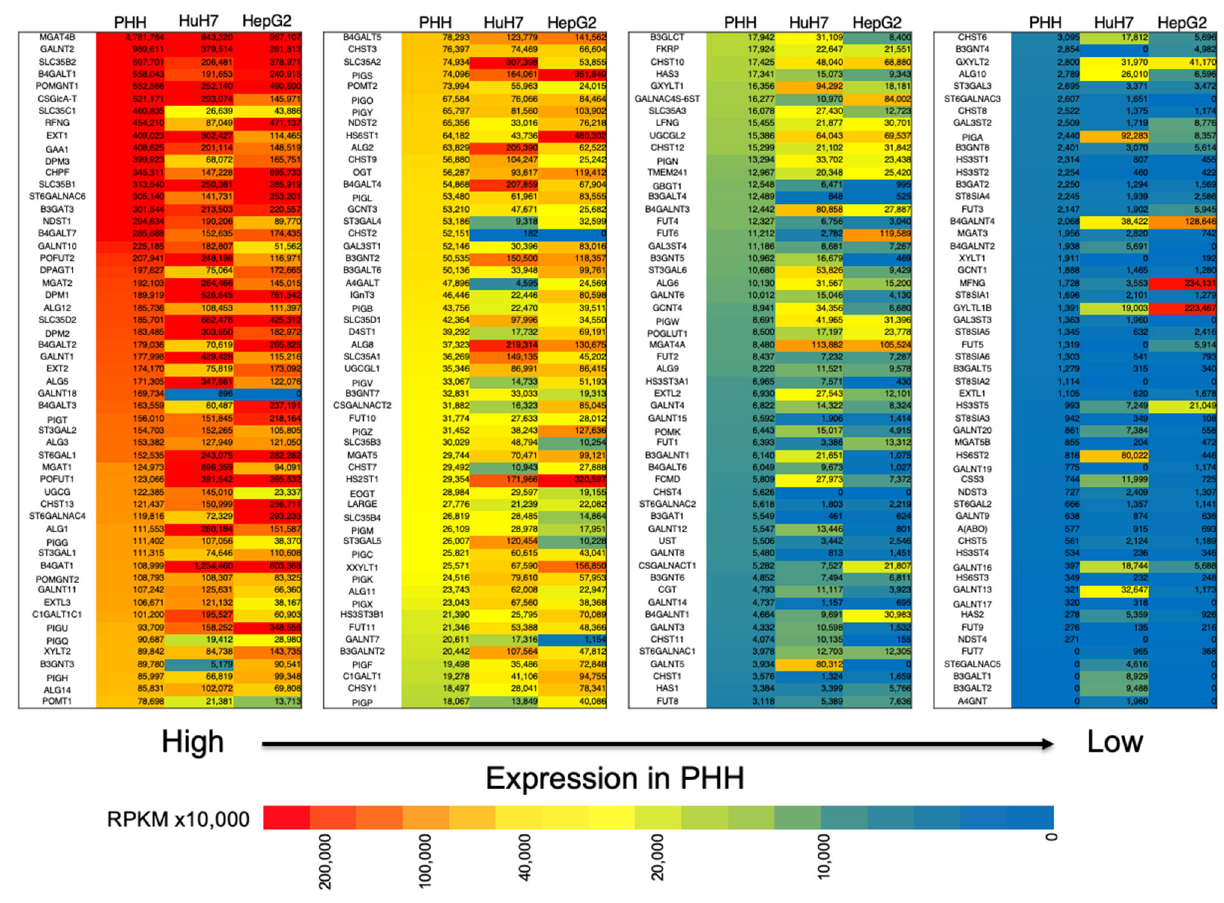
Frontiers in Oncology |